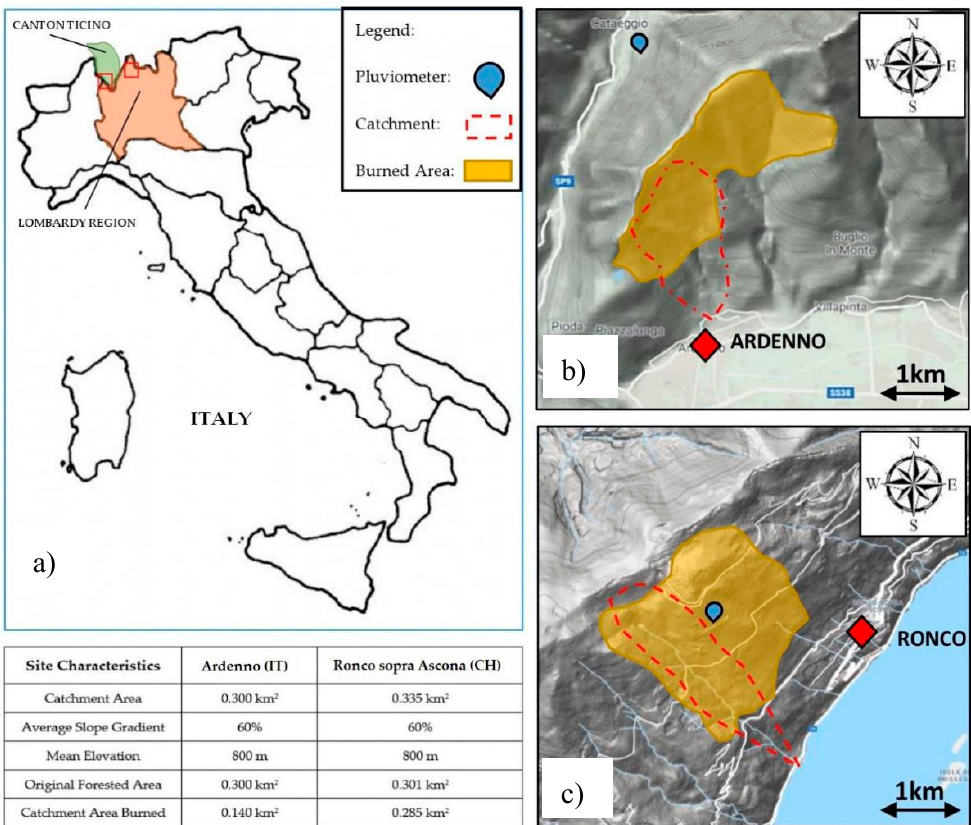
Figure 3. ( a ) The Ardenno and Ronco sopra Ascona locations in the Lombardy Region (Italy) and Canton Ticino (Switzerland), respectively. ( b , c ) Wildfire extension (orange), Catchment limits (red) and rain gauge location (blue dot); table of the Site characteristics of Ardenno and Ronco sopra Ascona areas.